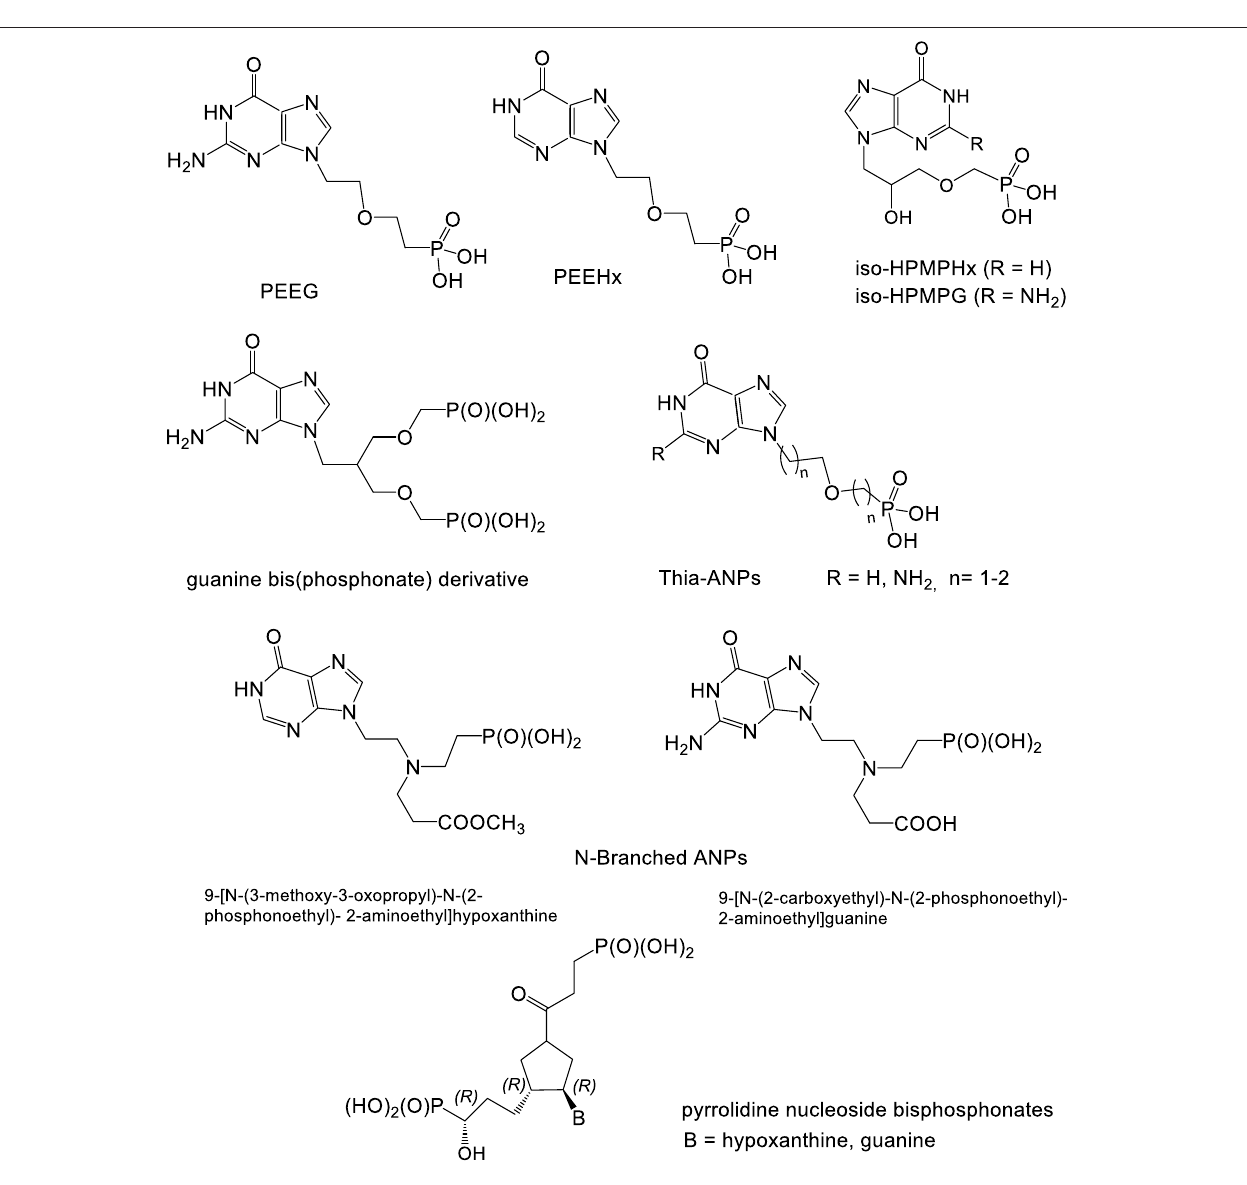
Frontiers in Chemistry |